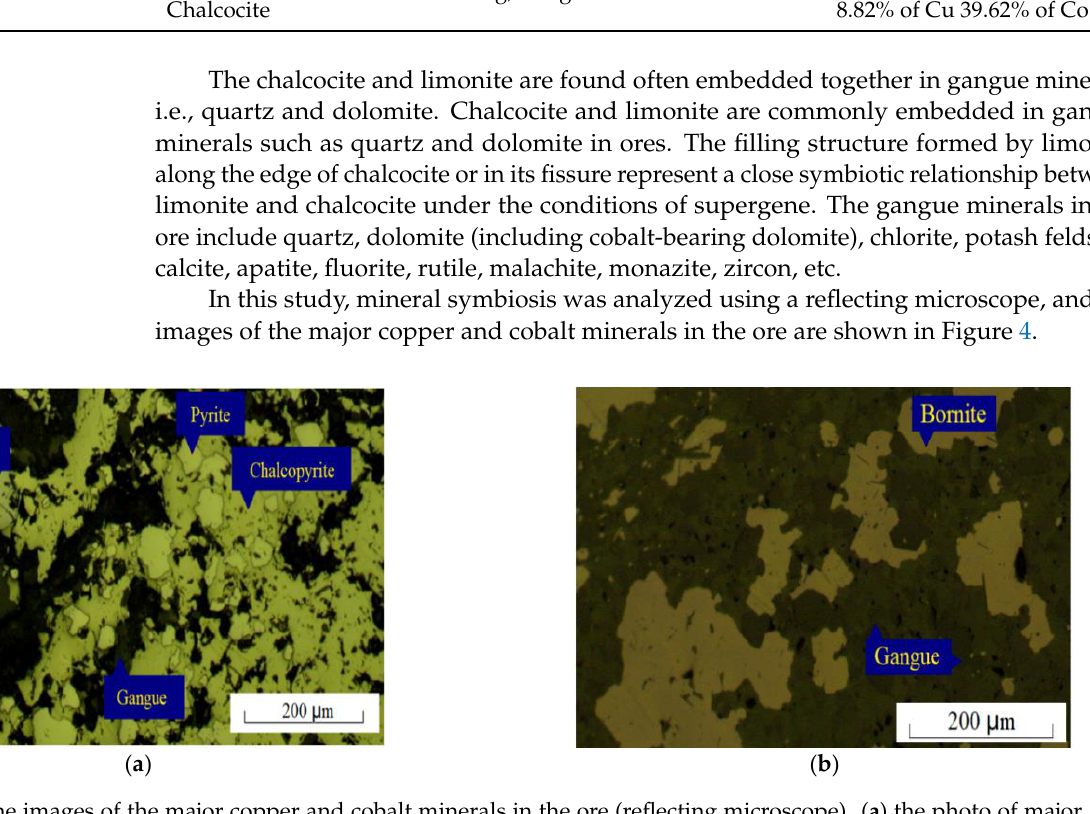
Figure 4. The images of the major copper and cobalt minerals in the ore (reflecting microscope). ( a ) the photo of major copper and cobalt minerals ( b ) the photo of copper and gangue minerals.